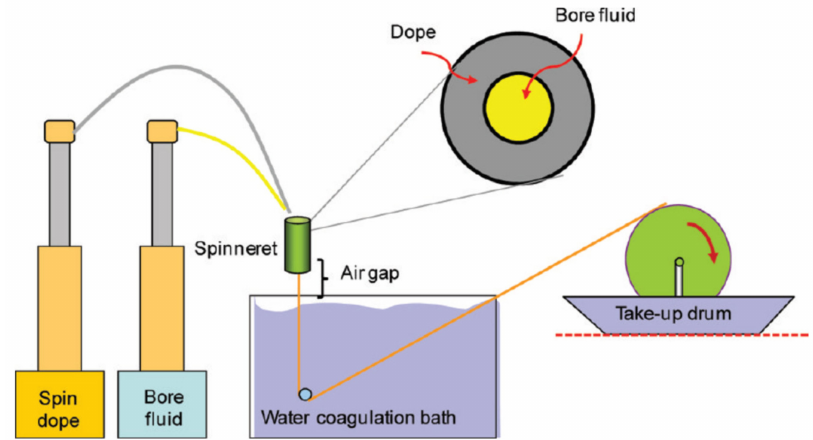
Figure 10. Illustration of the dry jet-wet quench spinning technique. Reprinted with permission from [91]. Copyright © 2010 American Chemical